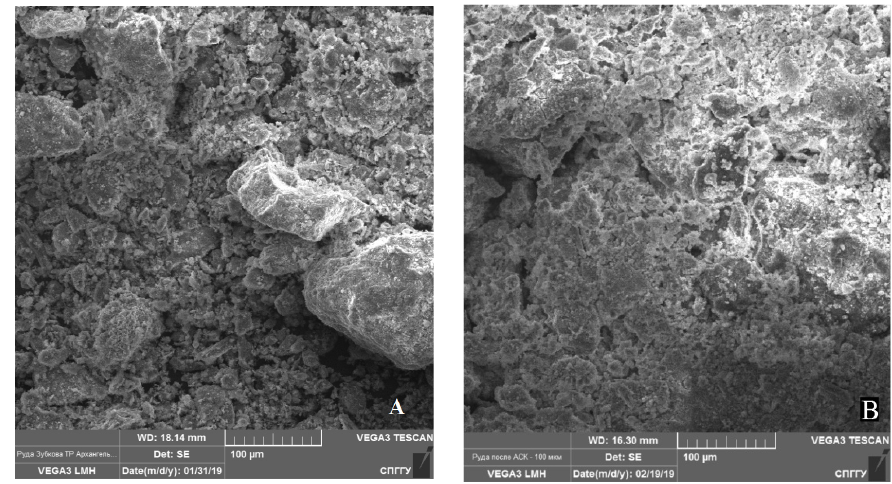
Figure 7. Pictures of the ore sample: ( A ) before precipitation with a calcium–aluminum–silicate reagent (field of view WD-18 mm), ( B ) after treatment with a reagent (field of view WD-16 mm).